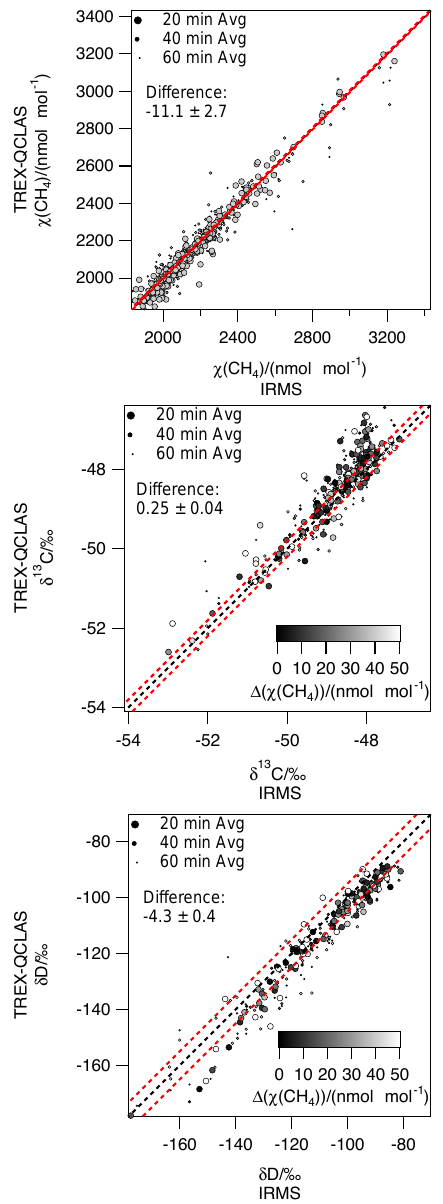
Figure 3. Correlation diagrams for CH 4 mole fraction, δ 13 C and δ D analyzed with IRMS (Utrecht University) and TREX- QCLAS (Empa). The dashed black lines are 1 : 1 lines; dashed red lines mark the extended WMO compatibility goals of ± 5nmolmol − 1 , ± 0.2‰ and ± 5‰ for CH 4 mole fraction, δ 13 C and δ D, respectively. The temporal difference between IRMS and TREX-QCLAS sampling is indicated by the point size (large: 20min; medium: 40min; small: 60min). For δ 13 C and δ D, the dif- ferences in the CH 4 mole fraction of the measurements are rep- resented by the shading (black: identical mole fractions; white: 50nmolmol − 1